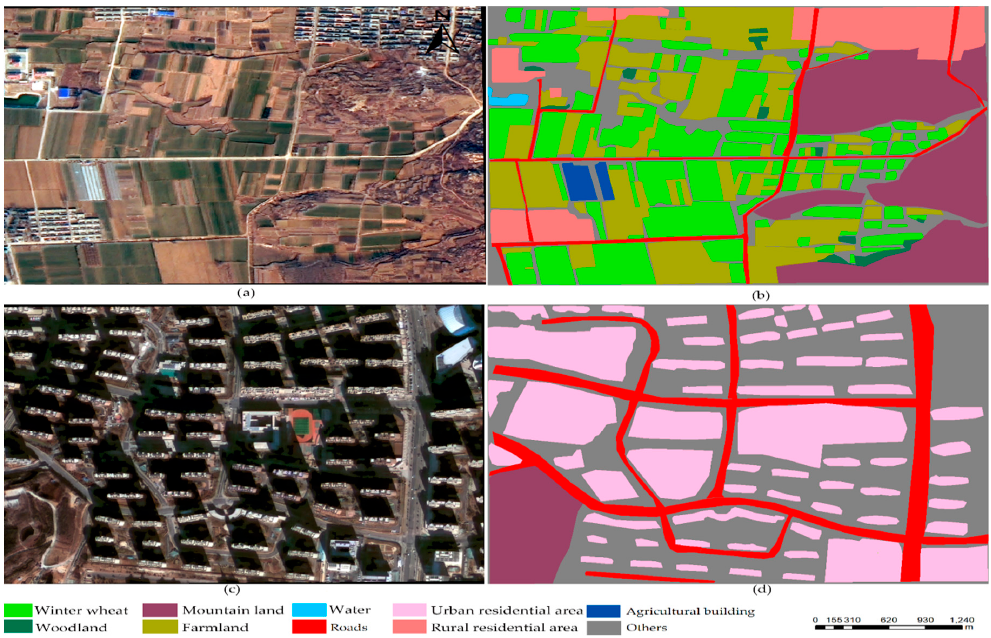
Figure 2. An example of an image–label pair used for testing the proposed method: ( a ) image block, ( b ) manually-labeled image corresponding to (a), ( c ) image block, and ( d ) manually-labeled image corresponding to (c).